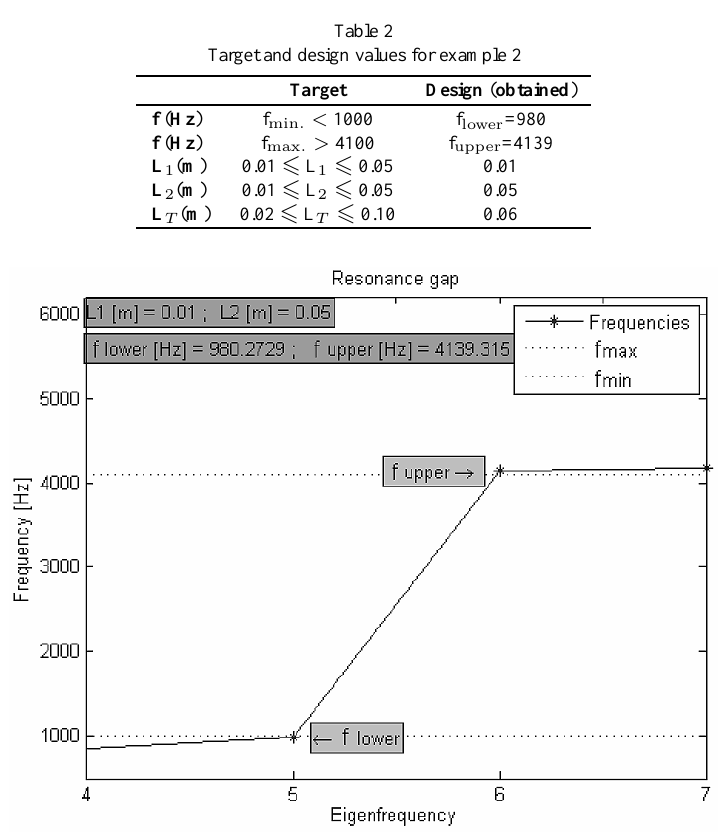
Fig. 10. Resonance gap obtained for example